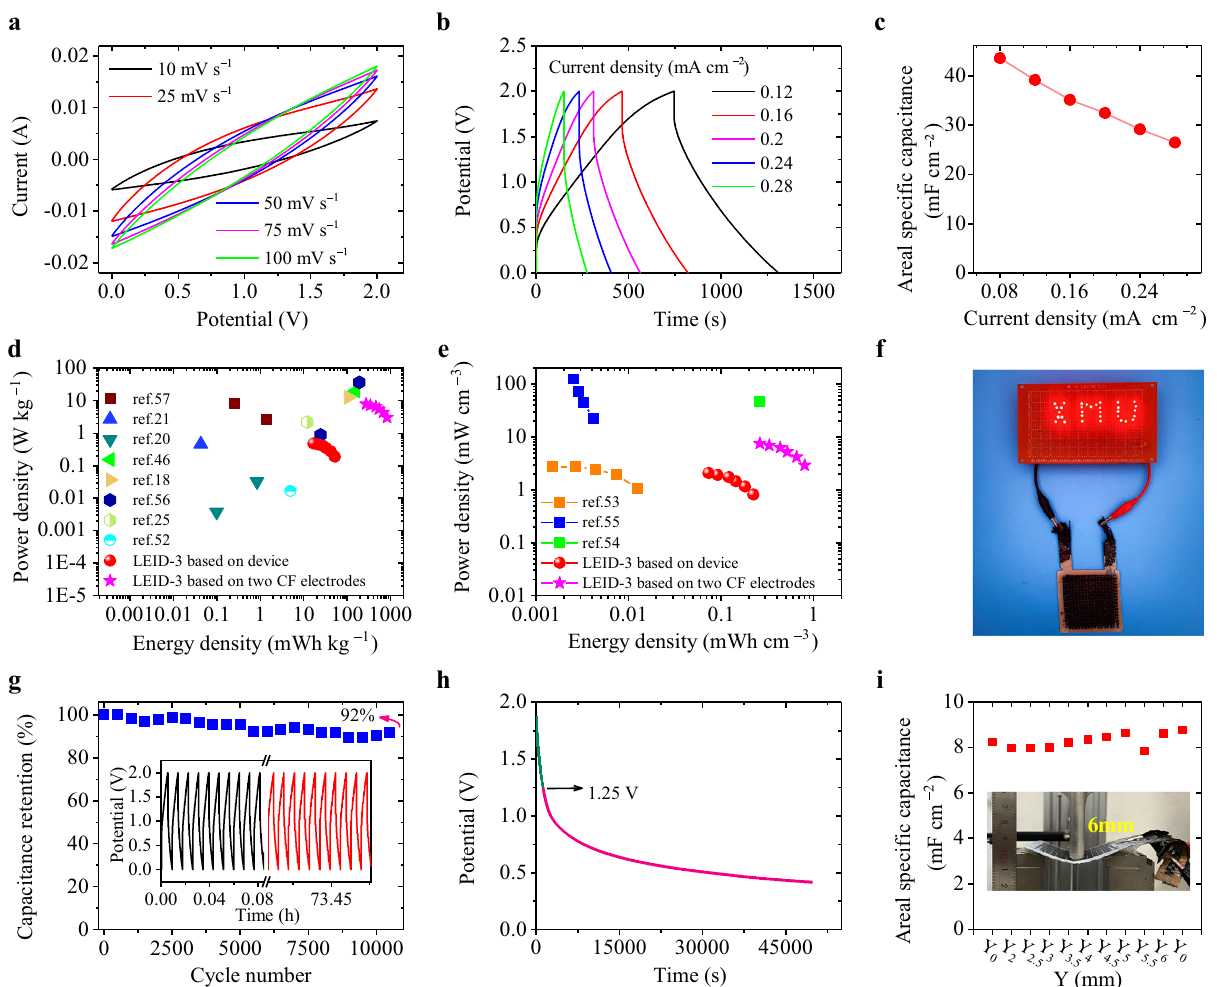
Fig. 4 | Electrochemical properties of LEID-3. a CV curves of LEID-3 at different scanning rates. b GCD curves of LEID-3 under different current densities. c Areal speci fi ccapacitanceofLEID-3atdifferentcurrentdensities. d , e Ragoneplotsofthe LEID-3 and literature data. (Based on device: the energy and power densities were calculated based on the mass or volume of the whole device, including the CF electrodes,GFseparator,and solid electrolyte. Based on CF electrodes: the energy